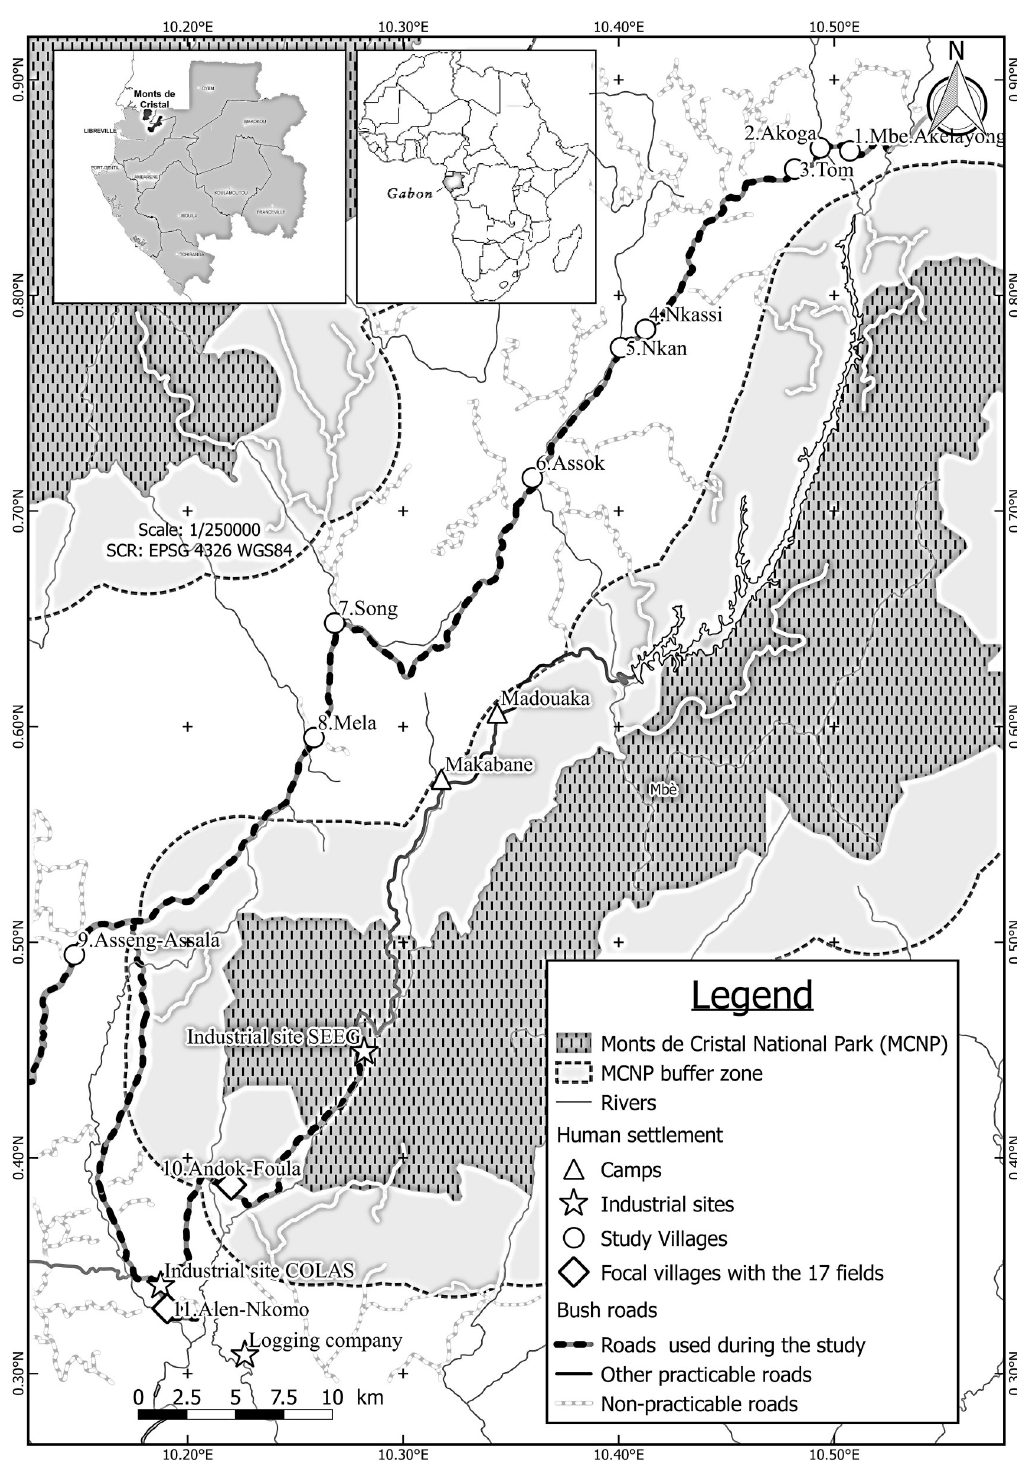
Fig 1. (Study site, TIF file): Mont de Cristal National Park (MCNP) and its buffer zones. With the exception of the southern part of the park, villages are located outside of buffer zones.